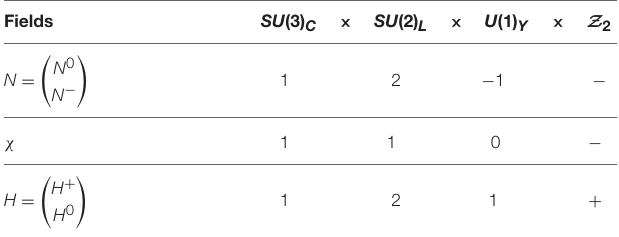
for sin α 0.001 (Left) and sin α = 1